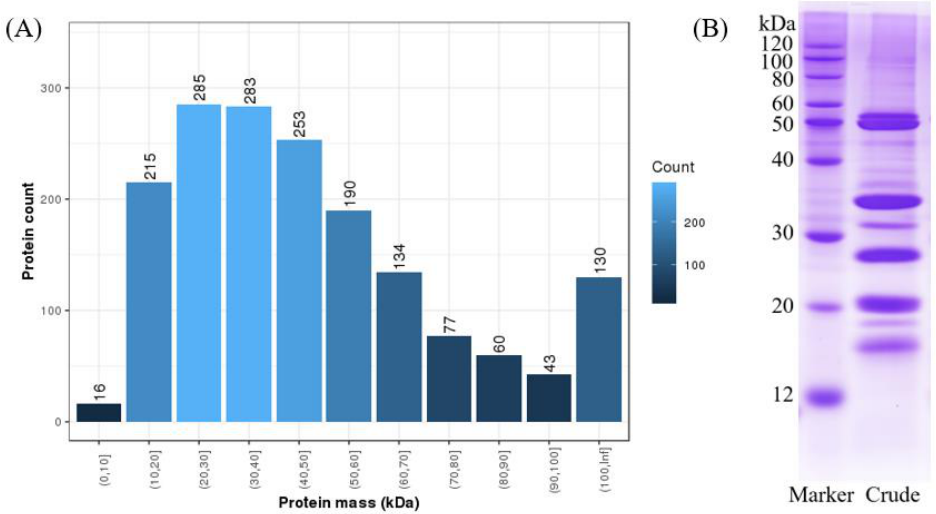
Figure 1. ( A ) Distribution of protein mass. ( B ) SDS-PAGE 12% profiles of the extracted proteins of C. nucifera sample.